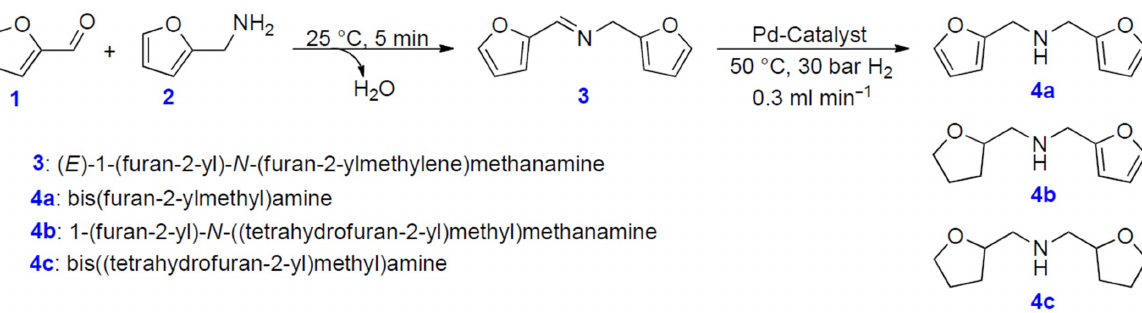
Figure 6. Catalysts screening in the reductive amination of furfural. Reaction conditions: 3 (0.1 M in methanol), catalyst (50 mg), 50 °C, 30 bar H 2 , flow rate (0.3 mL min − 1 ). Conversion and selectivity were determined by GC. In order to confirm the essential role of the catalytic system in the reaction progress, blank measurements were performed in the absence of any catalyst. Furthermore, considering that hydrogen-donor solvents (especially methanol, ethanol and isopropanol) are often used to supply molecular hydrogen in hydrogenation reactions [29], blank tests were also performed in the absence of hydrogen pressure. This analysis revealed that in the absence of any catalyst and hydrogen pressure, the reaction displayed <1% conversion, confirming not only the fundamental role of the catalyst, but also that hydrogen gas was the only source. On the other hand, Pd-N/C a and Pd-N/C b showed comparable catalytic activity. Indeed, over both catalytic systems, quantitative conversion of 3 was achieved. However, a slight difference in the products’ distribution was observed. In detail, over Pd-N/C a , 4a and 4b were obtained with 81% and 19% selectivity, respectively, while over Pd-N/C b the same products were obtained with 86% and 14% selectivity, respectively, suggesting the better performance of Pd-N/C a . Similar behavior was noticed when using commercial Pd/C. The conversion was stable and quantitative, but it brought about a change in the products’ distribution due to the concurrent formation of 4a (58%), 4b (36%)